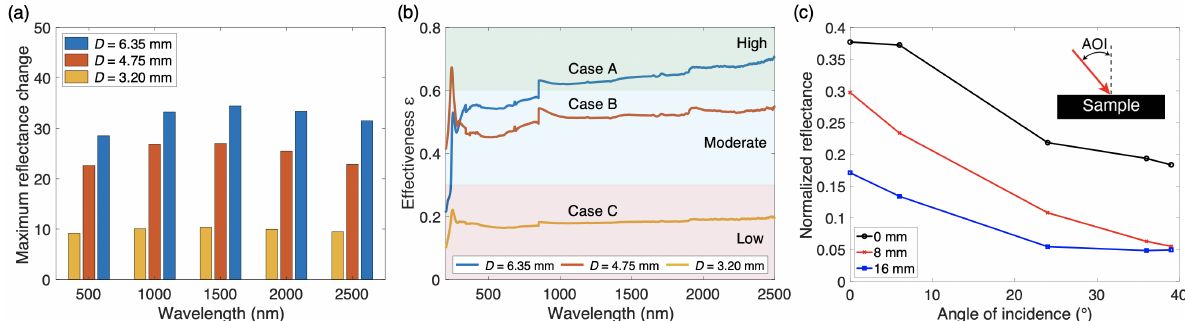
Figure 5. Evaluation of tunability performance. ( a ) Direct comparison of maximum reflectance change for each structure at five wavelength values. The maximum change is based upon a modulation between the non-displaced and 32 mm-displaced states. ( b ) Effectiveness of piston-type tunability with 32 mm actuation in modulating reflectance. ( c ) Spectra results for three displacements of Case A at various angles of incidence (AOI), normalized with respect to the AM 1.5 solar irradiance data to present an average result. The inset illustrates how the AOI is defined with respect to the